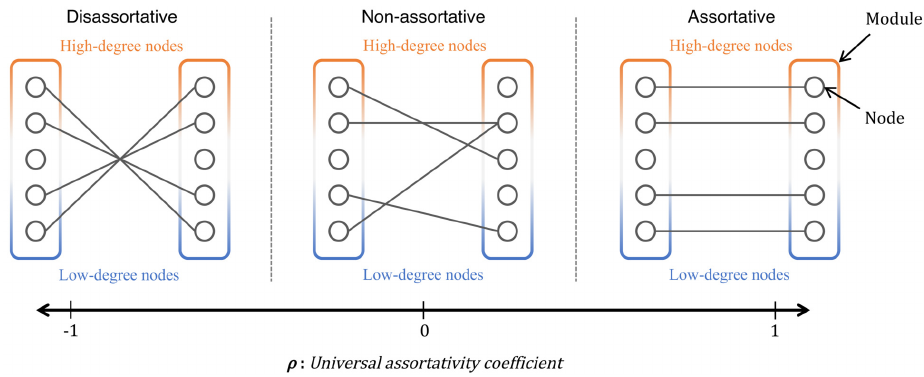
Figure 4. Relationship between universal assortativity coefficient and inter-modular connectivity.